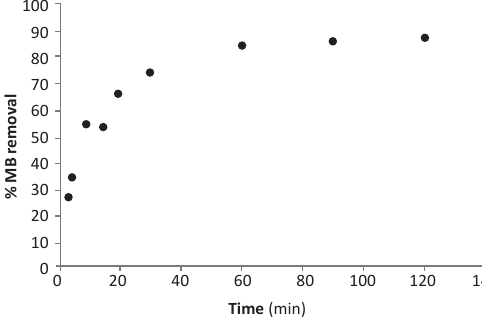
figURe 5. The effect of contact time on the adsorption of MB onto poplar sawdust (γ t=120 min, T=298.15 K, pH=7, 150 rpm).